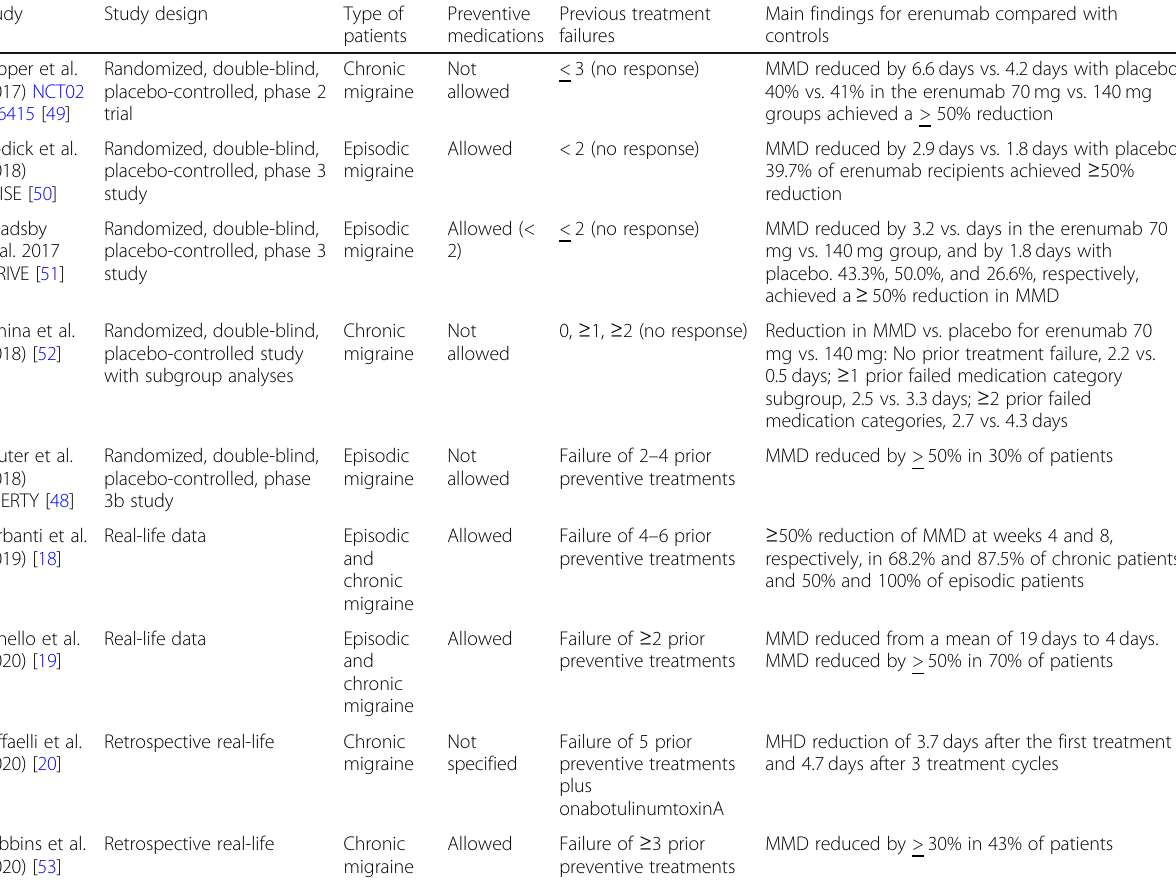
Table 4 Synoptic review of randomized controlled trials and real-life experiences using erenumab as a preventive treatment for